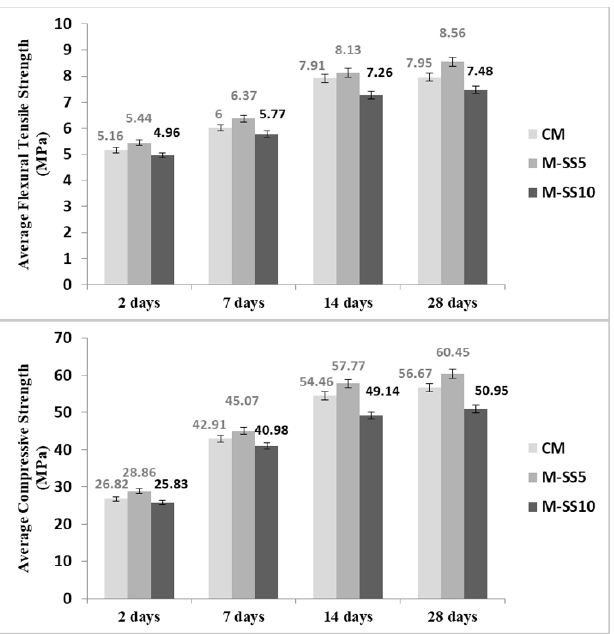
Figure 10. Average compressive and flexural tensile strengths at different ages of the mixtures with SS additions.